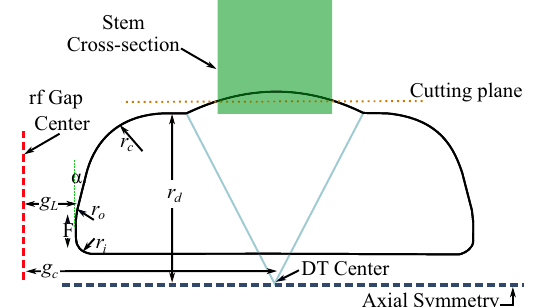
FIG. 6. A cross-sectional view of a drift tube. The drift tube is rotationally symmetric with respect to the beam axis. The geometry of a half drift tube is determined by eight parameters which are shown here. A kind of midsphere, centered on the drift tube, eases the production of the stem-to-drift-tube junction.